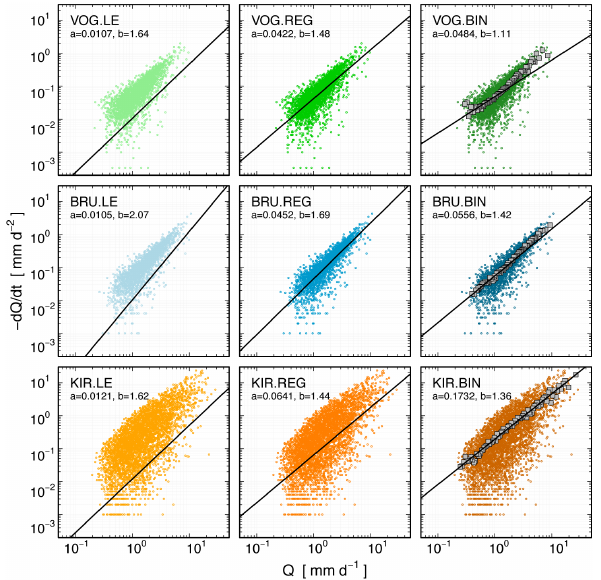
Fig. 1. Recession plots with intercepts a and slopes b for three extraction procedures (VOG, BRU, KIR) and three different fitted models (lower envelope, linear regression, binning). Daily stream- flow data from the Kinzig